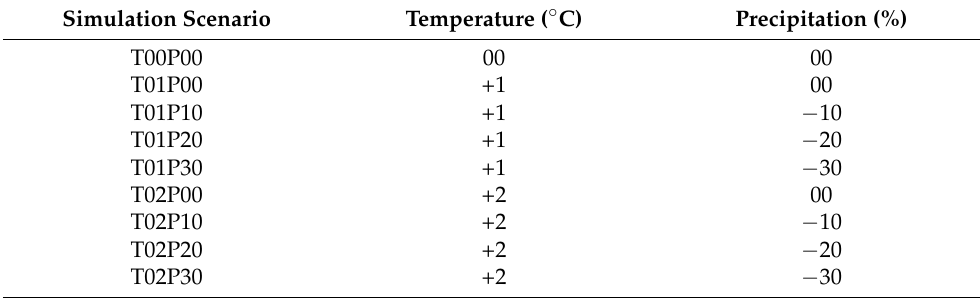
Table 1. Simulation scenarios that include changes in temperature and